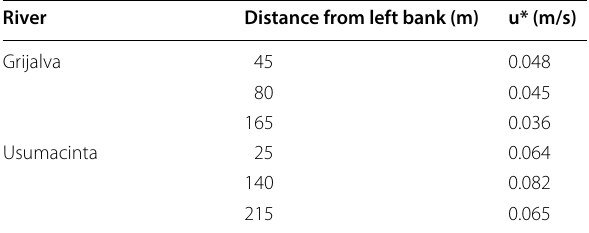
Table 1 Shear velocity in Usumacinta and Grijalva rivers River Distance from left bank